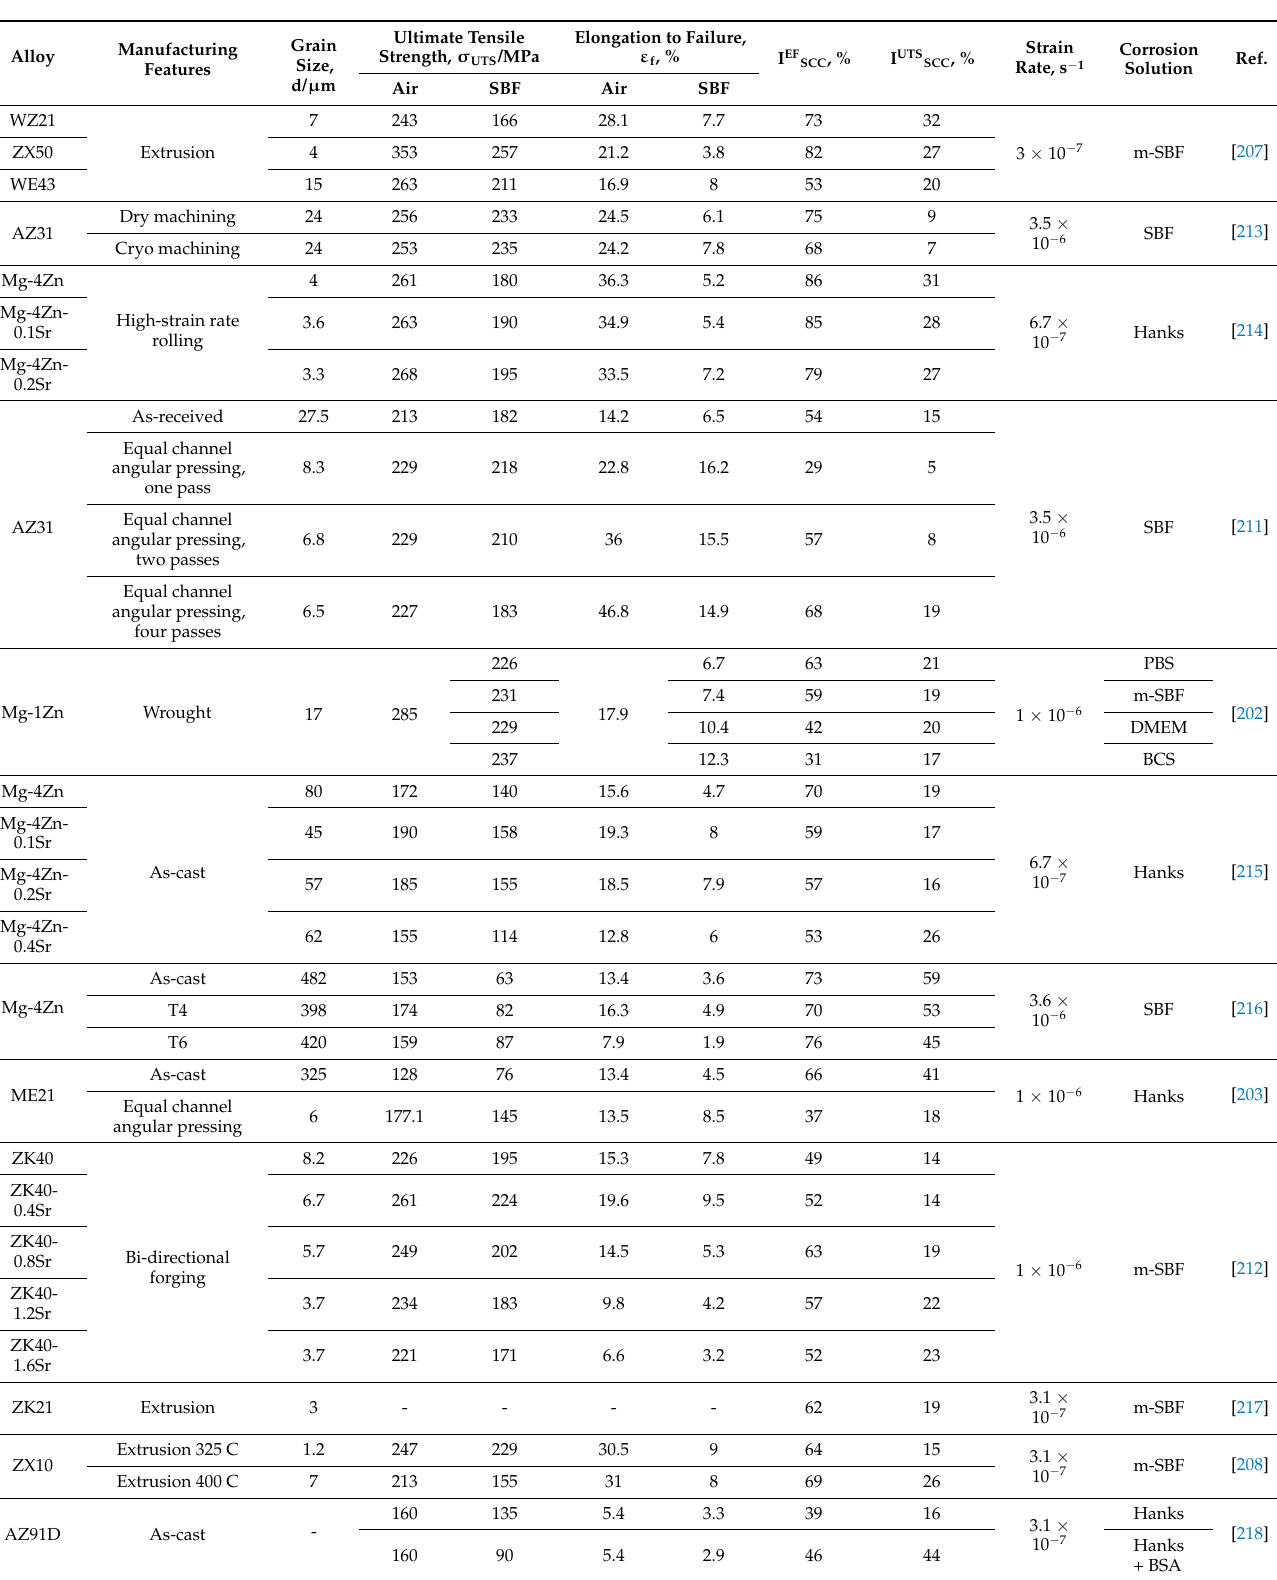
Table 5. The SCC performance of the biodegradable Mg alloys in